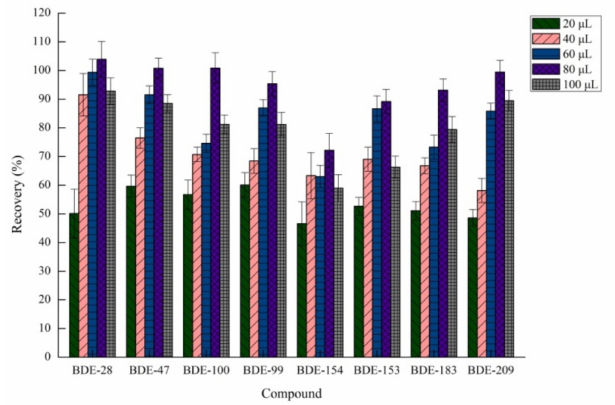
Figure 2. Effect of volume of extraction solvent on recovery ( n =